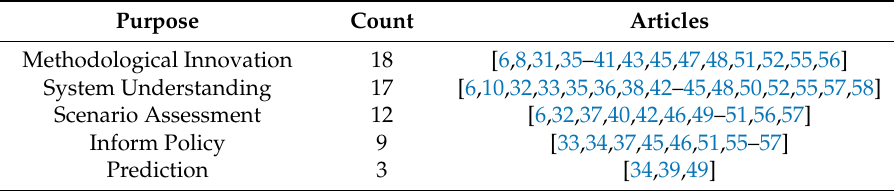
Table 2. Total count and associated articles that stated a given modeling purpose. Many articles stated more than one purpose, in which case an article will appear in more than one